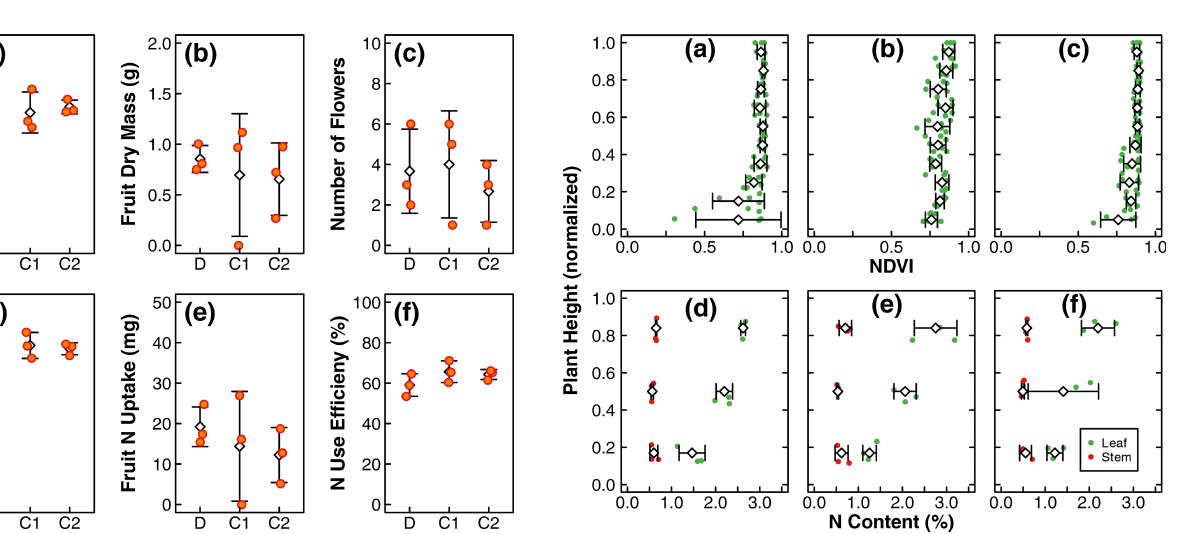
Figure 3. Leaf NDVI as a function of normalized plant height at the end of the experiments in treatments D (b) , C1 (b) , and C2 (c) . N content (%) of stem and leaf samples across the canopy at the end of the experiments in treatments D (d) , C1 (e) , and C2 (f) . The green dots represent leaf samples, while the red dots represent stem sam- ples. The dots include three replicates within each treatment. The diamonds and whiskers represent the mean and standard deviation of replicates at the normalized plant height. Note: mean and stan- dard deviation of leaf NDVI was calculated within an incremental height of 0 . 1. N content (%) of stem and leaf samples was sepa- rated into three portions across the canopy and thus reported as the normalized height of 0 . 17, 0 . 5, and 0 .